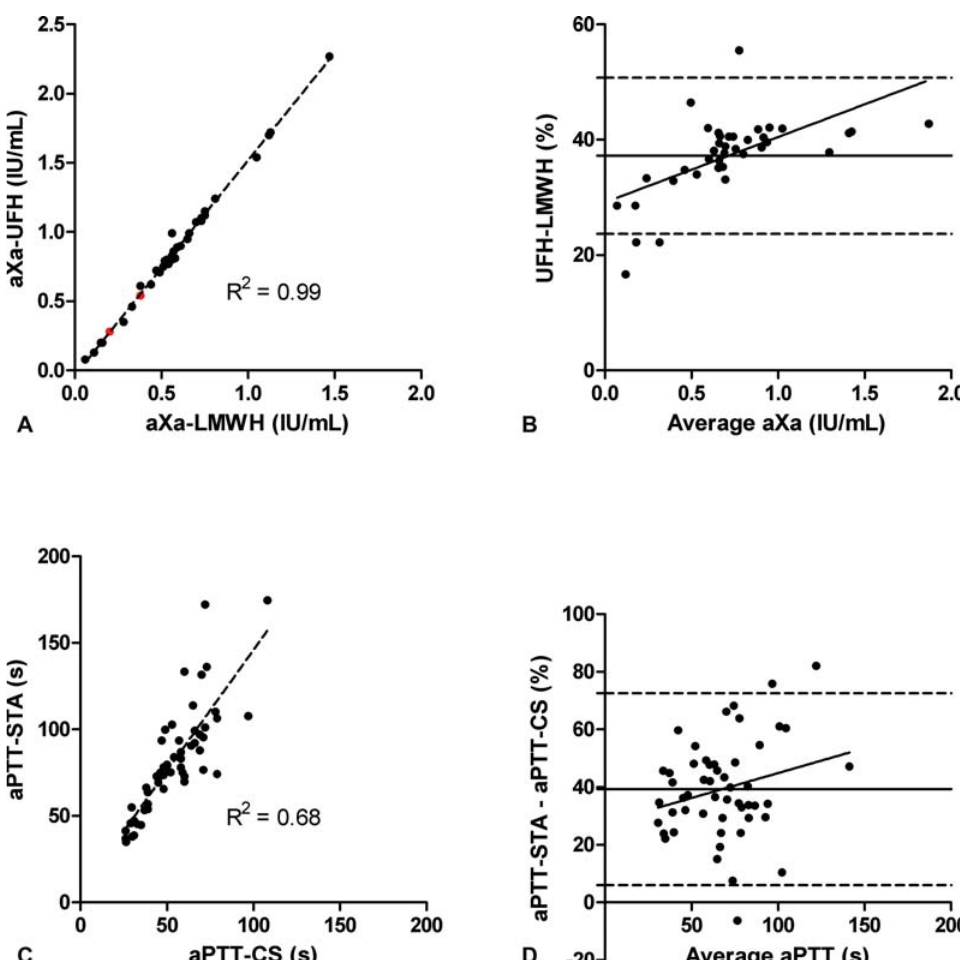
Fig. 2 ( A ) Correlation of the anti-Xa assay with the unfractionated heparin (UFH) and the low-molecular-weight heparin (LMWH) calibration. The two red samples are internal quality control samples for the UFH calibration. ( B ) Bland – Altman plot of the relative difference between the UFH and LMWH calibrations versus the average aXa activity. ( C ) Correlation of the activated partial thromboplastin time (aPTT) as measured with the mechanical (aPTT-STA) versus the optical (aPTT-CS) method. ( D ) Bland – Altman plotof the relative difference between the aPTT-STA andaPTT-CS versus the average aPTT. Bland – Altman plots show the relative bias (thick lines) and the 95% limit of agreement (dashed